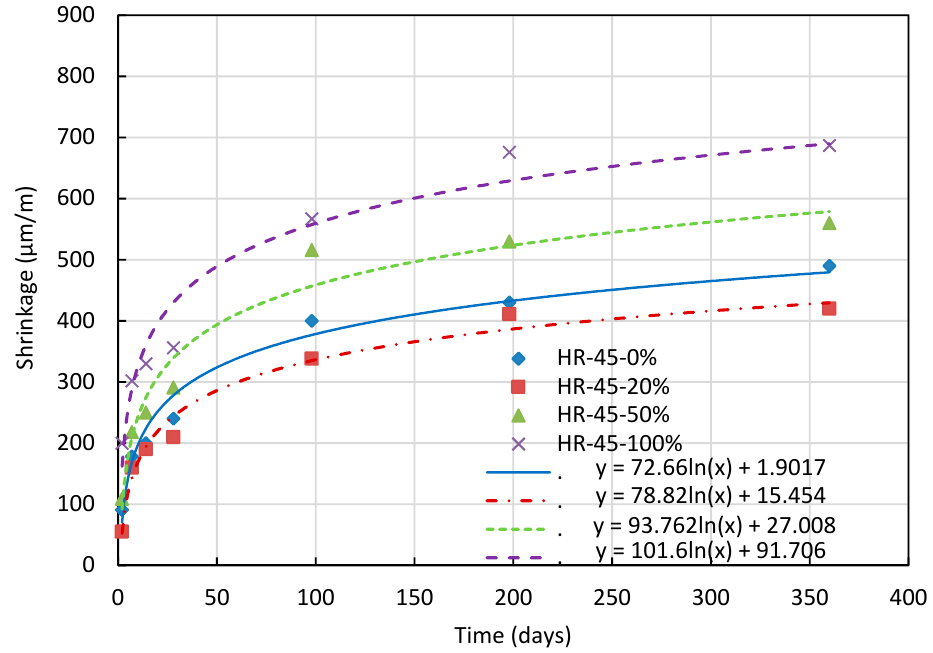
Figure 7. Evolution of the shrinkage vs. time of the HR-45 concrete.